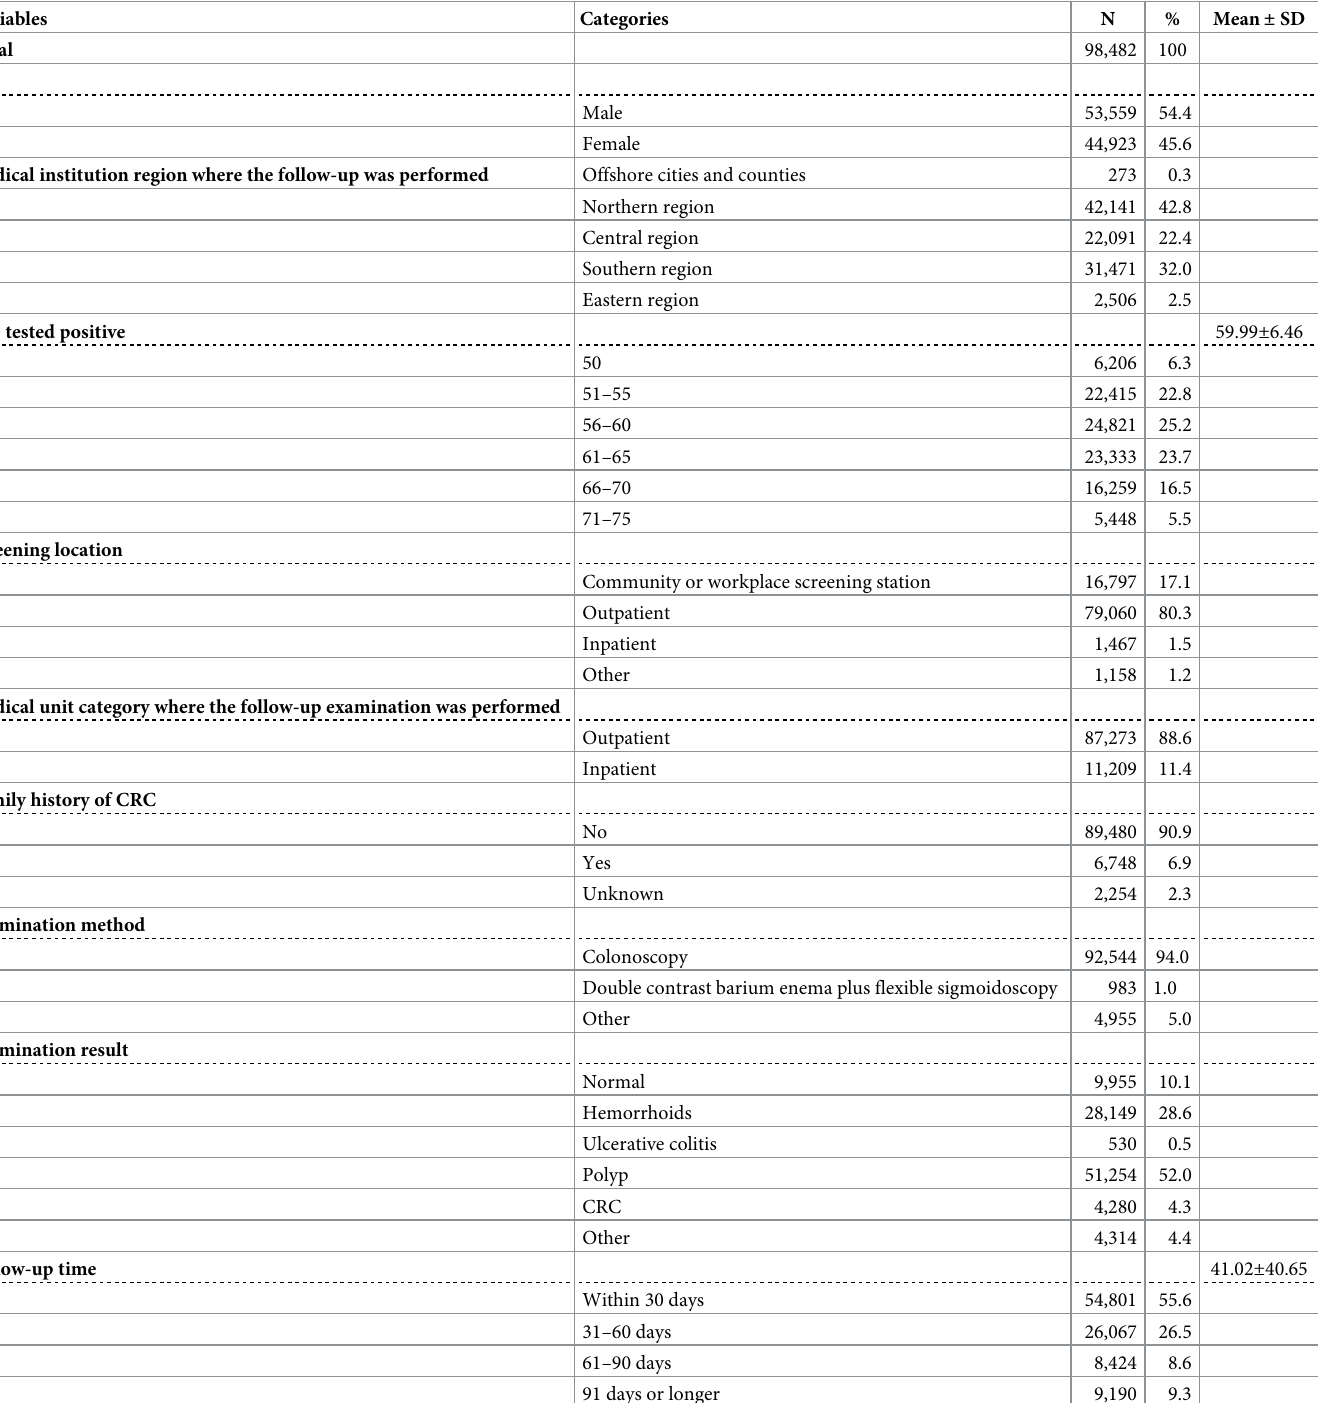
Table 2. General information of the population positive for FOBT that underwent follow-up